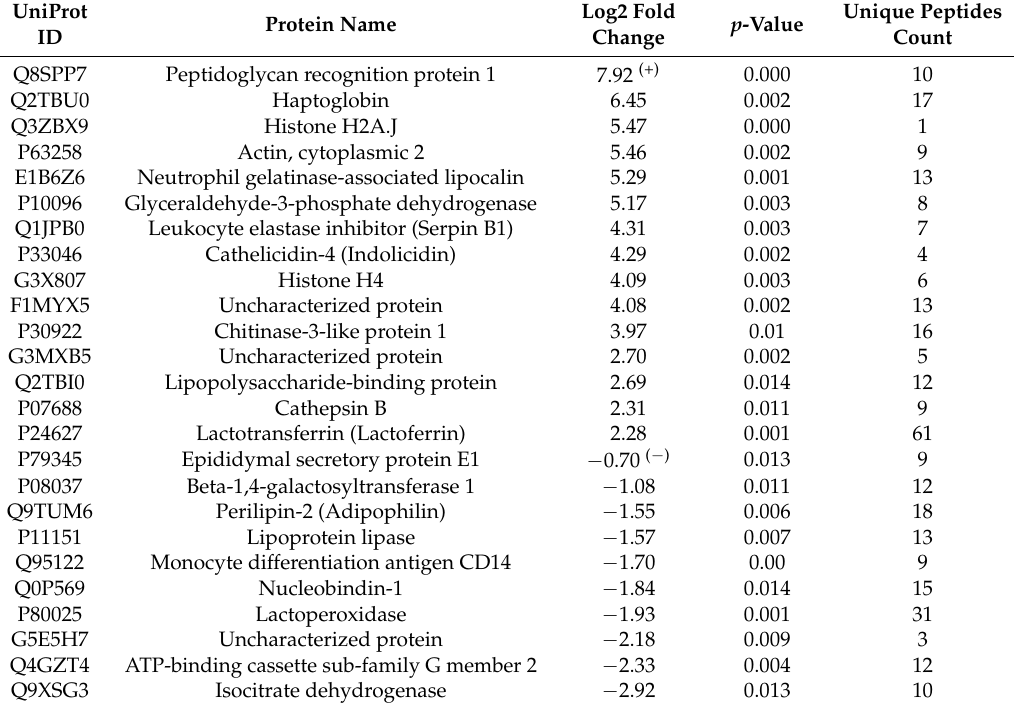
Table 1. Proteins significantly high-abundant or low-abundant by the presence of Staphylococcus aureus identified by LC-MS/MS analysis in whey milk samples when compared to the control samples.